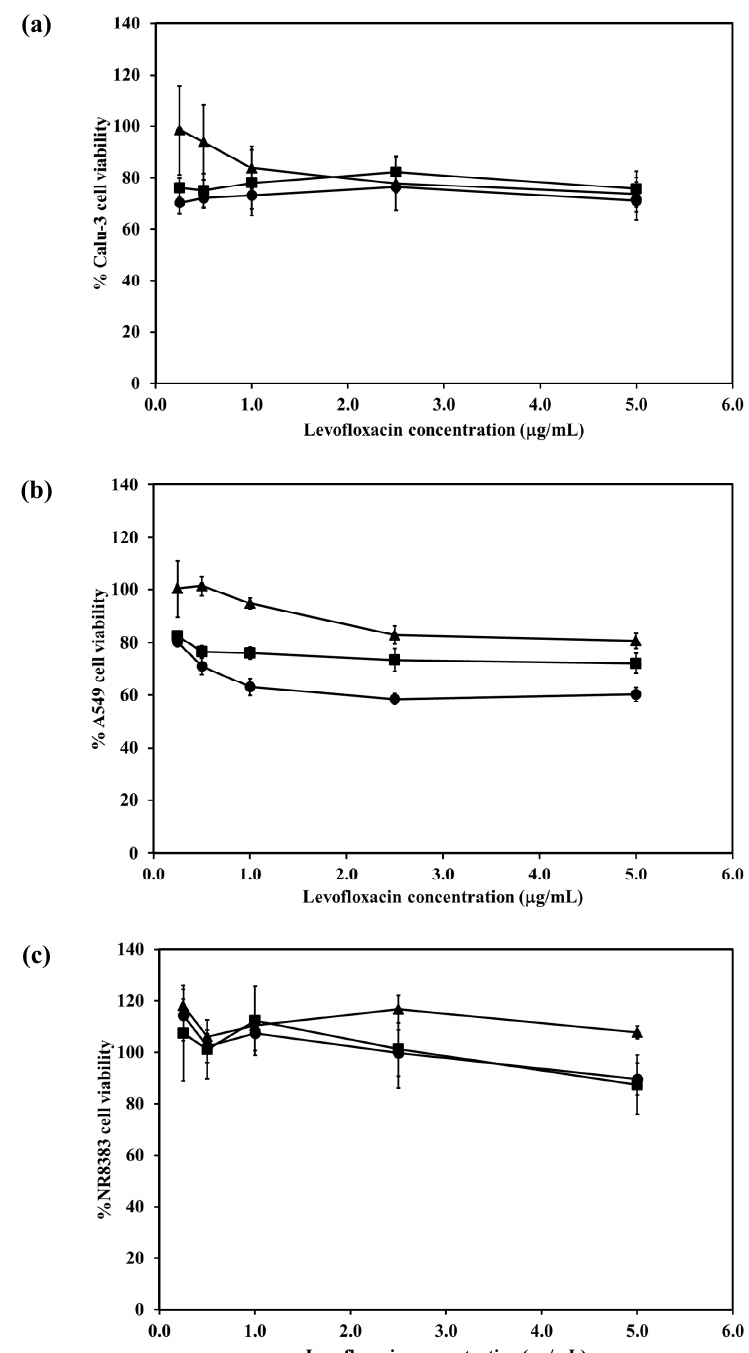
Figure 5. Viability of ( a ) Calu-3; ( b ) A549; ( c ) NR8383 cell lines after exposed to different concentrations of LEV ( ● ); LEV-proliposome formulation No.1 ( ▲ ); LEV-proliposome formulation No.5 ( ■ ) (mean  SD, n ≥ 6).